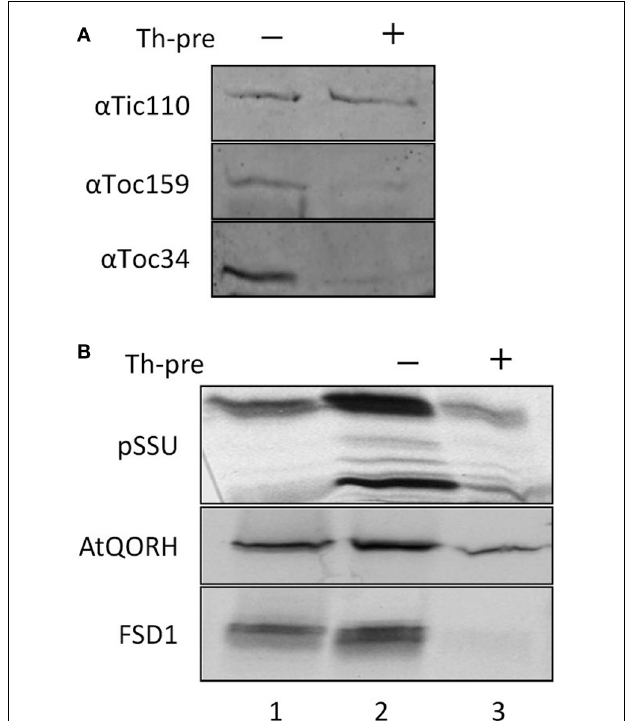
FIGURE 3 | FSD1 import critically depends on protease sensitive surface receptors. (A) Immunoblot of chloroplasts used for import experiments before and after thermolysin pre-treatment. The membrane was probed for Tic110, Toc159, and Toc34. Representative results from n = 3 independent experiments are depicted. (B) In vitro import assays into pea chloroplasts are depicted. Lane 1 shows 10% of translation product. Thl-pre ( + ) indicates thermolysin digestion before the import reaction (lane 3). All samples were treated with thermolysin after import.